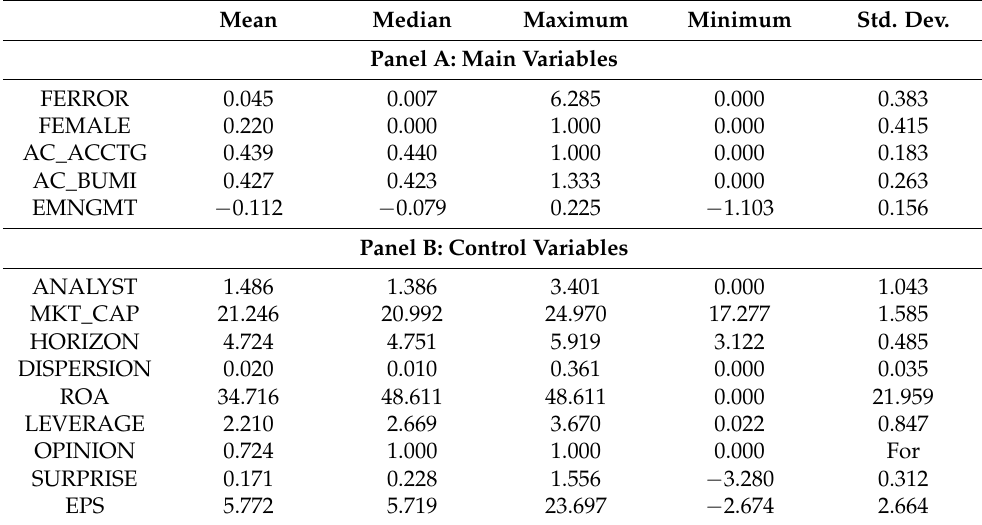
Table 3. Descriptive Analysis of Variables used in the